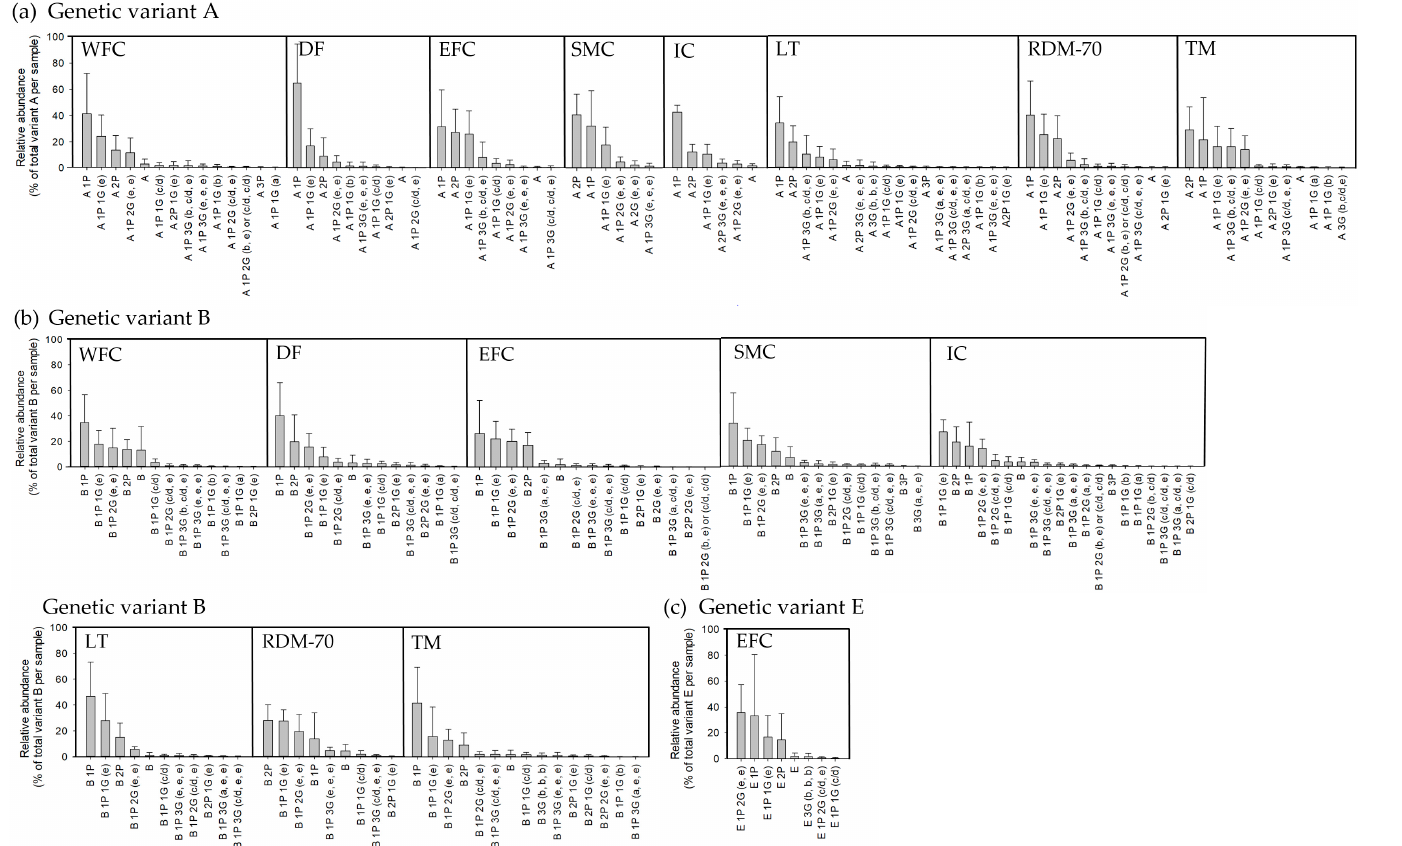
Figure 2. Prevalence of distinct glycomacropeptide (GMP) isoforms relative to total GMP (mean ± SD). ( a ) Genetic Variant A, ( b ) genetic Variant B and ( c ) genetic Variant E in milk from Western Finncattle (WFC), Norwegian Doela cattle (DOL), Eastern Finncattle (EFC), Swedish Mountain cattle (SMC), Icelandic cattle (IC), native Lithuania Black and White cattle (LT), Danish Red anno 1970 (RDM-70), Norwegian Telemark cattle (TM). A, B and E = genetic Variants A, B and E, P = phosphorylation, G = glycans, a–e = the five common O -linked glycans attached to κ